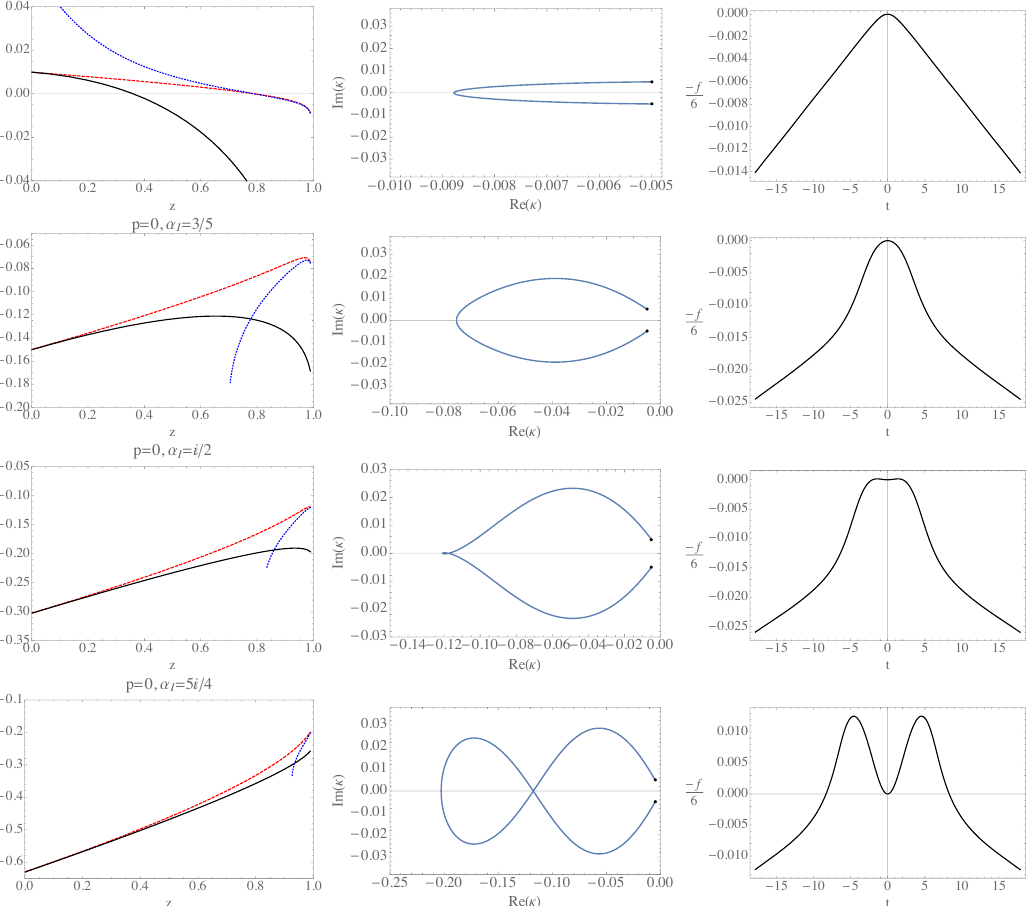
Figure 13 . Leading ( p = 0) saddle for the (cid:11) respectively). Left: interpolation between z ( black, solid ) is the large (cid:20) /small z approximation, ( blue, dotted ) is the small ( (cid:20) becomes complex where the curve ends), and ( red, dashed ) is the exact numeric result. Middle: Trajectory of the p = 0 saddle at (cid:12)xed (where Im( (cid:20) ) < 0). At t = 0, it crosses the real axis, where the value of (cid:20) matches the value at z 1 in the left plot. Right : plot of the term (cid:25) 1 z = 0 : 11 as a function of t , from integrating (cid:20) ; the integration constant has been chosen so j (cid:0) j f (0) = 0. Parameters (cid:11) L = 0 : 99 ; (cid:11) H = i are chosen as in (cid:12)gure 9. Thus we see that some saddles grow before their ultimate late-time